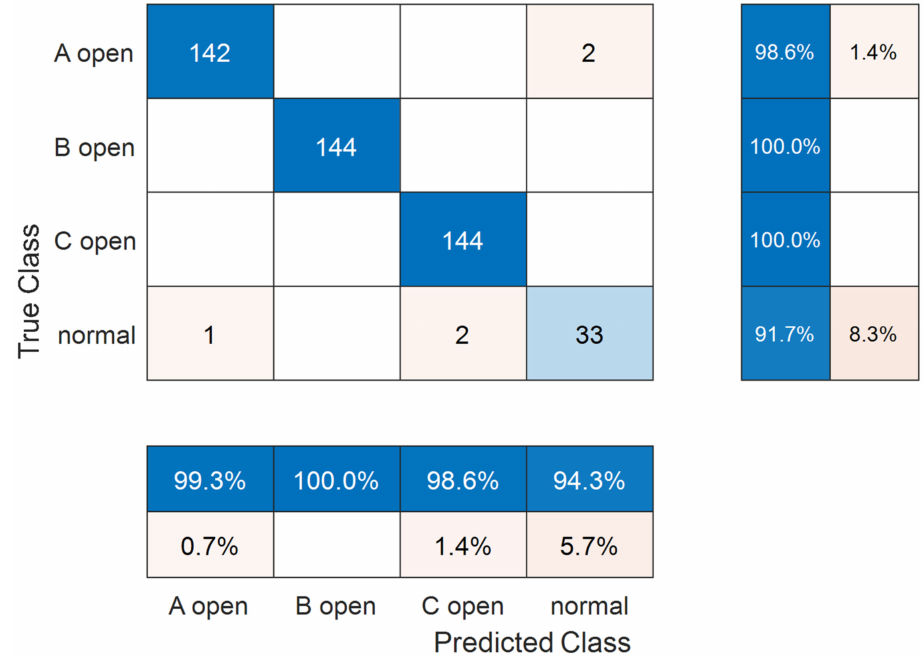
Figure 17. Confusion matrix of fault type classification model with 1/2 cycle data input.